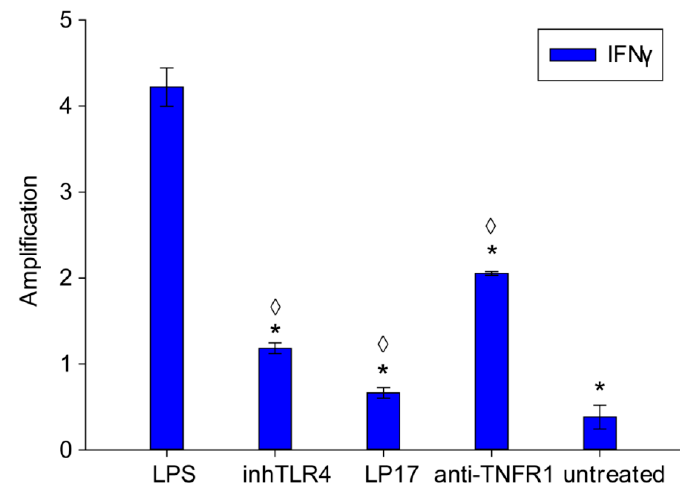
Figure 4. Changes in mRNA expression of IFN γ in PBMCs treated with LPS blocking of TLR4, TREM-1 and TNFR1 receptors. PBMCs incubated with LPS (100 ng/mL) only or in presence of inhTLR4, LP17 and anti-TNFR1 antibodies for 12 h. All values were normalized to control (before any treatment). Level of mRNA was measured by RT-PCR with RPLP0 and GADPH as references (one-way ANOVA, p -value ♦ < 0.05 vs. untreated; one-way ANOVA, p -value * < 0.01 vs. LPS).